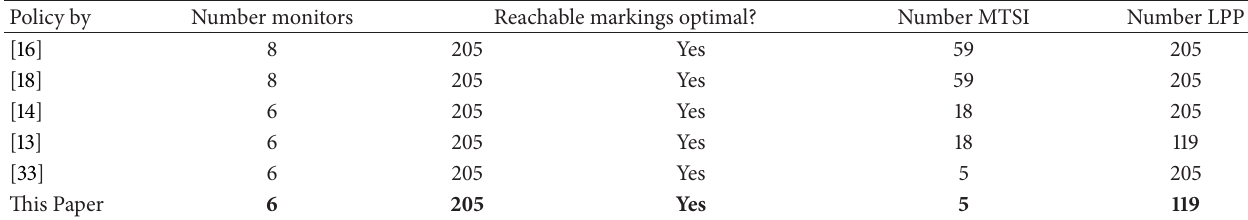
Table 11: Comparison of the controlled